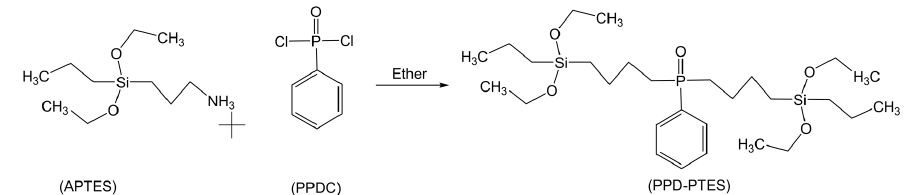
Figure 19. ( a ) Flammability test of untreated cotton fabric after 20 s ; ( b ) after 45 s ; ( c ) CPTS treated cotton after 20 s ; ( d ) after 67 s ; ( e ) MCPTS treated cotton after 20 s and ( f ) PCPTS treated cotton after 20 s (Reproduced from [147], with kind permission of Springer).